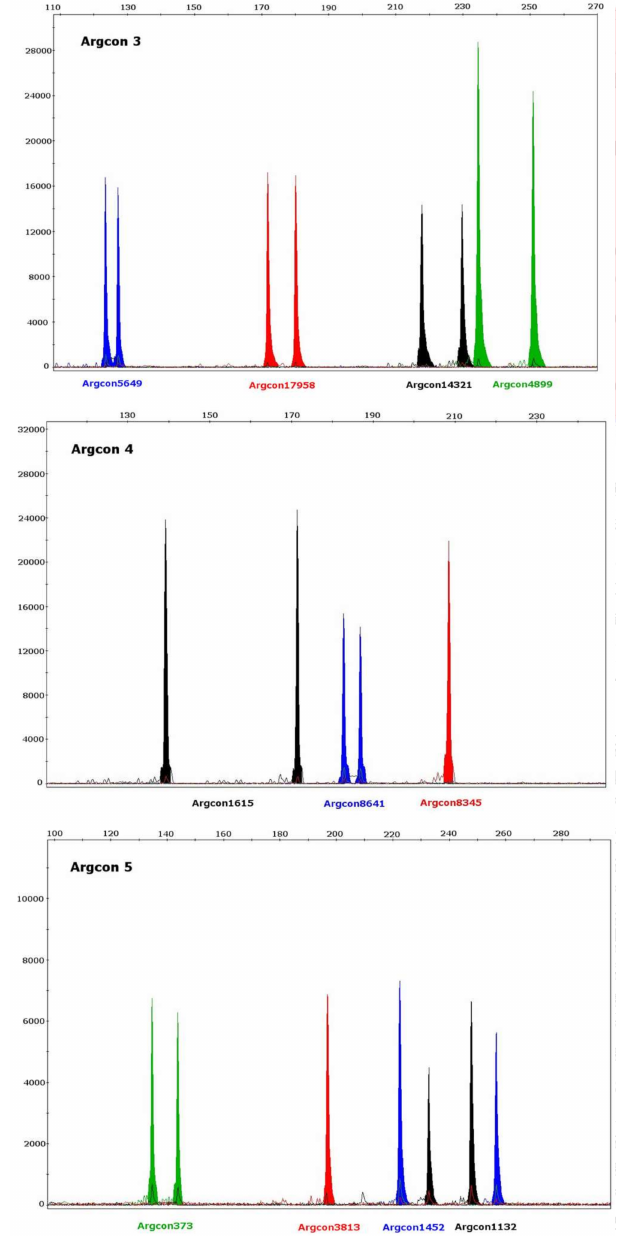
Figure 1. Chromatograms from capillary electrophoresis showing panels of the five multiplex PCRs (Argon 1 to Argon 5) for the 19 tetranucleotide STRs from the apple fruit moth ( Argyresthia conjugella ). The observed and expected heterozygosity obtained in the study varied from 0.1455 to 0.9074 and 0.4816 to 0.9399, respectively. The mean expected heterozygosity was He = 0.75, Nei’s genetic diversity index ranged from 0.4763 to 0.9399, and estimated F IS was 0.0486 to 0.6952 (Table 3). We also tested the 19 STRs using DNA from three species from the same genus; Argyresthia ivella , Argyresthia pruniella , and Argyresthia curvella . Cross-amplification could only be detected for two of the 19 STRs ( Argyresthia ivella : Arg1452 and, Argyresthia pruniella :